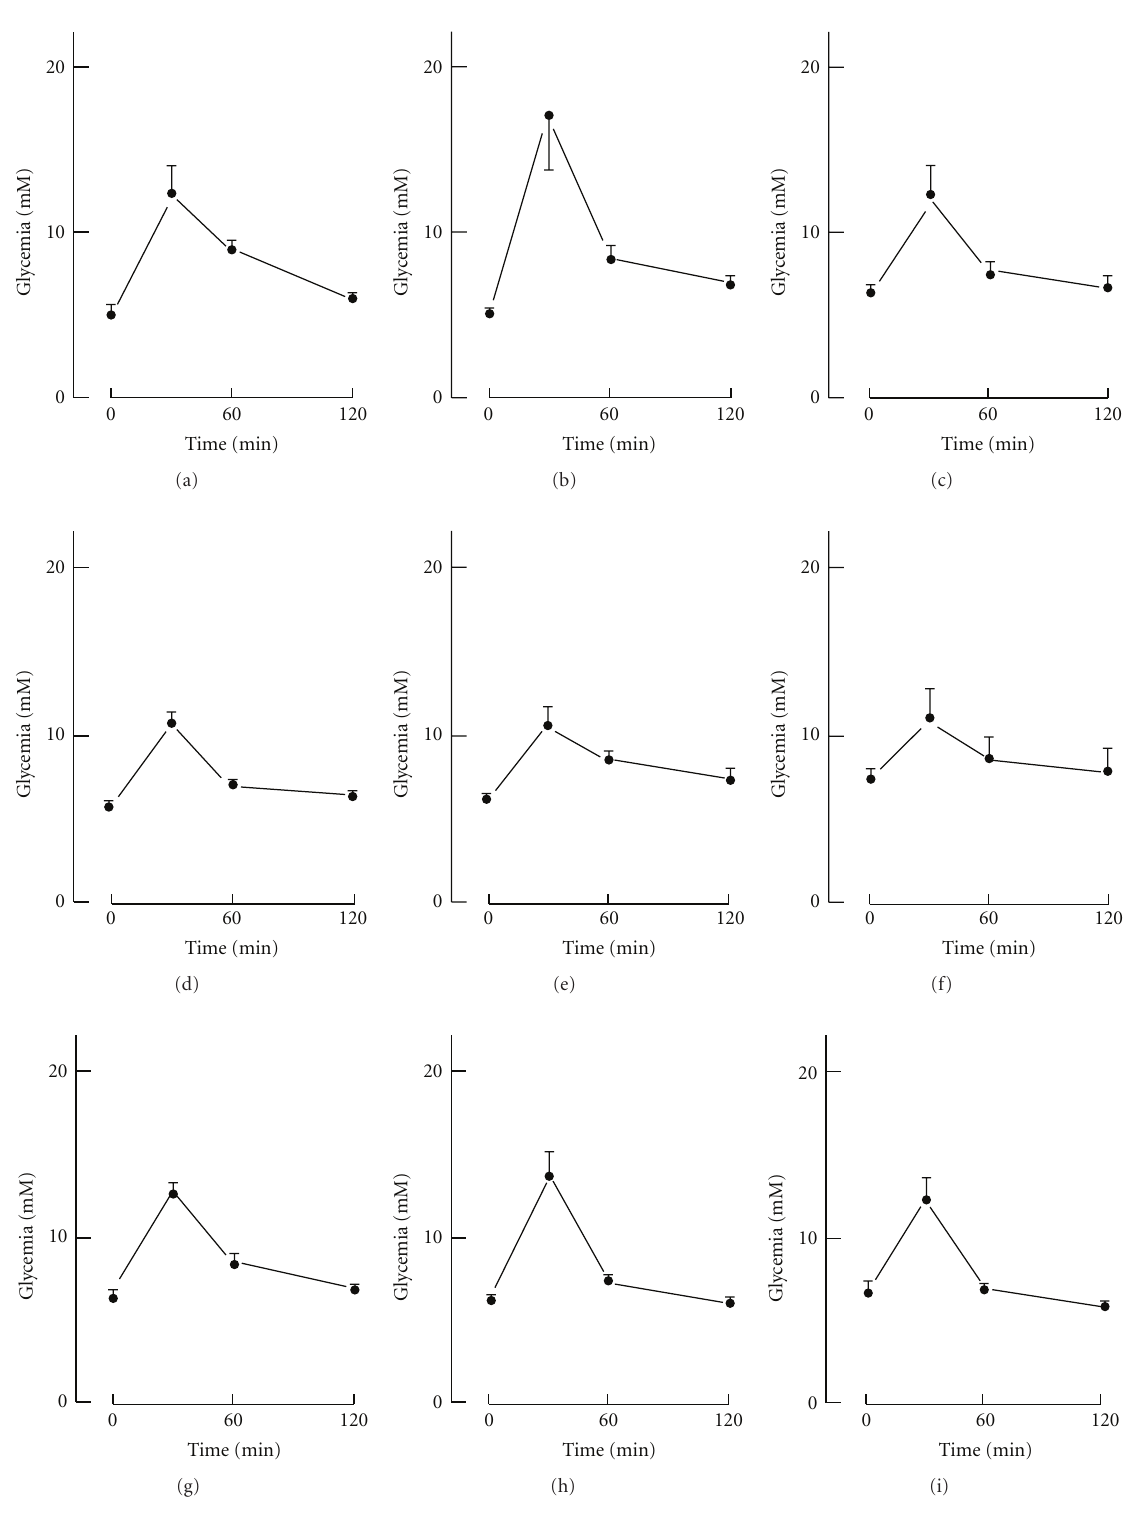
Figure 2: Glycemic profile during IPGTT conducted on day 10 (left), 20 (middle), and 29 (right) of the final experimental period in NF (upper panels), IF (middle panels), and CR (lower panels) control rats. Mean values ( ± SEM) refer to 5-6 individual